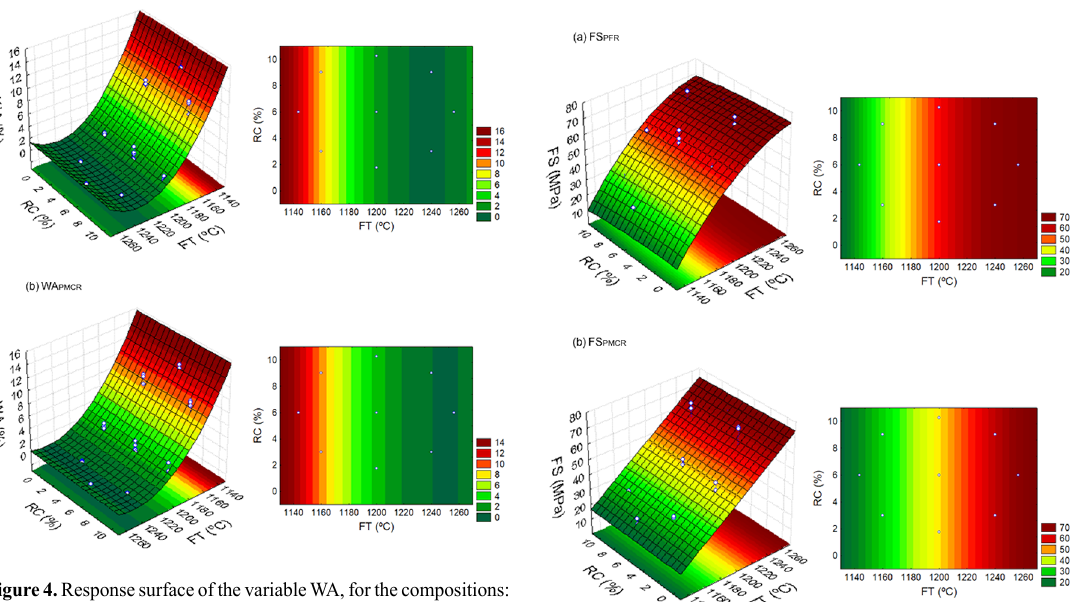
Figure 5. Response surface of the variable AD, for the compositions: (a) PFR and (b) PMCR.